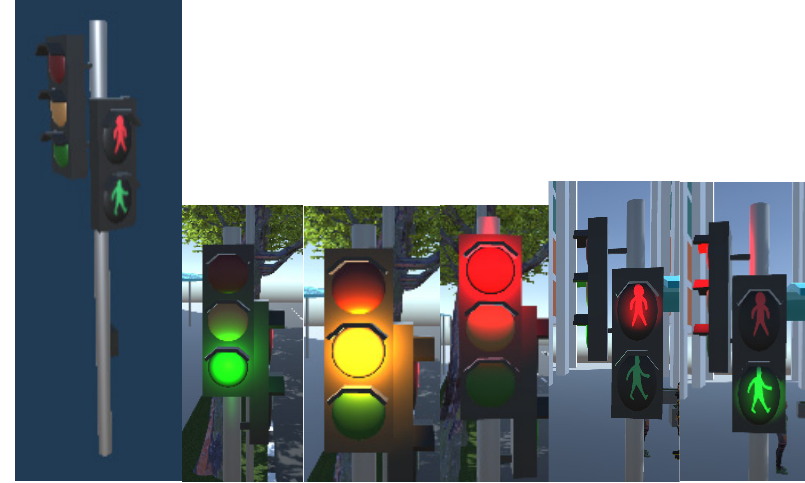
Figure 2. Structure of the designed traffic light.